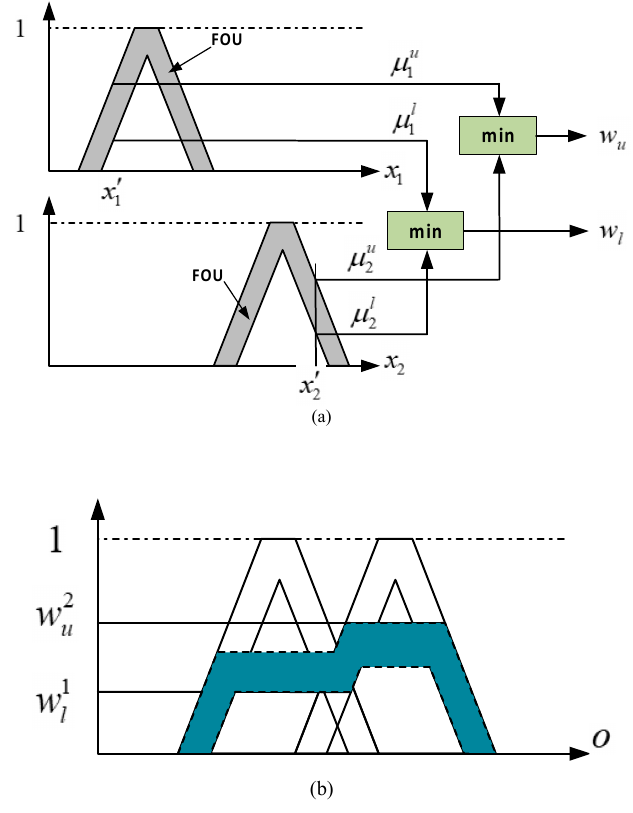
Figure 3. Type-2 fuzzy inference mechanism: ( a ) antecedent logical implication and ( b ) aggregated consequent set for two-rule evaluation.